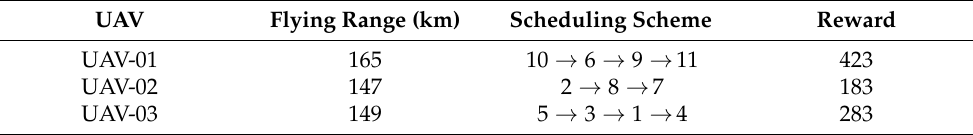
( c ) Figure 8. Task re-scheduling schemes with the emergency task based on buy-sell contract. ( a ) UAV-01; ( b ) UAV-02; ( c ) UAV-03. (2) Task re-scheduling based on replacement contract Three UAVs are employed to perform 10 tasks. Their information is shown in Table 2 and Table 7. The offline task scheduling scheme is reported in Table 8 and Figure 9.